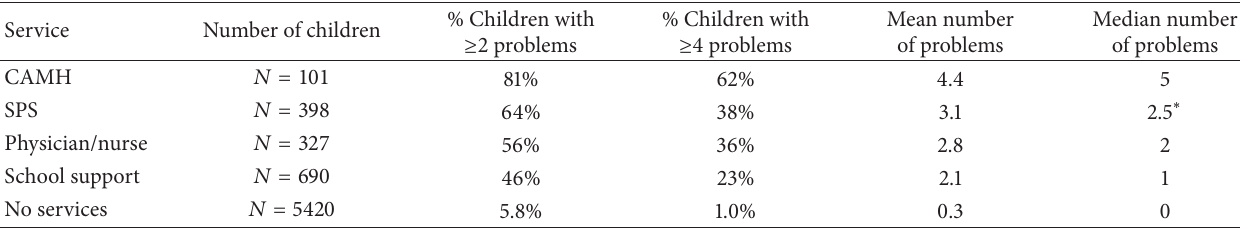
Table 4: Identified children, percent of referred children above 95th percentile on ≥ 2 and ≥ 4 problem areas, mean and median number